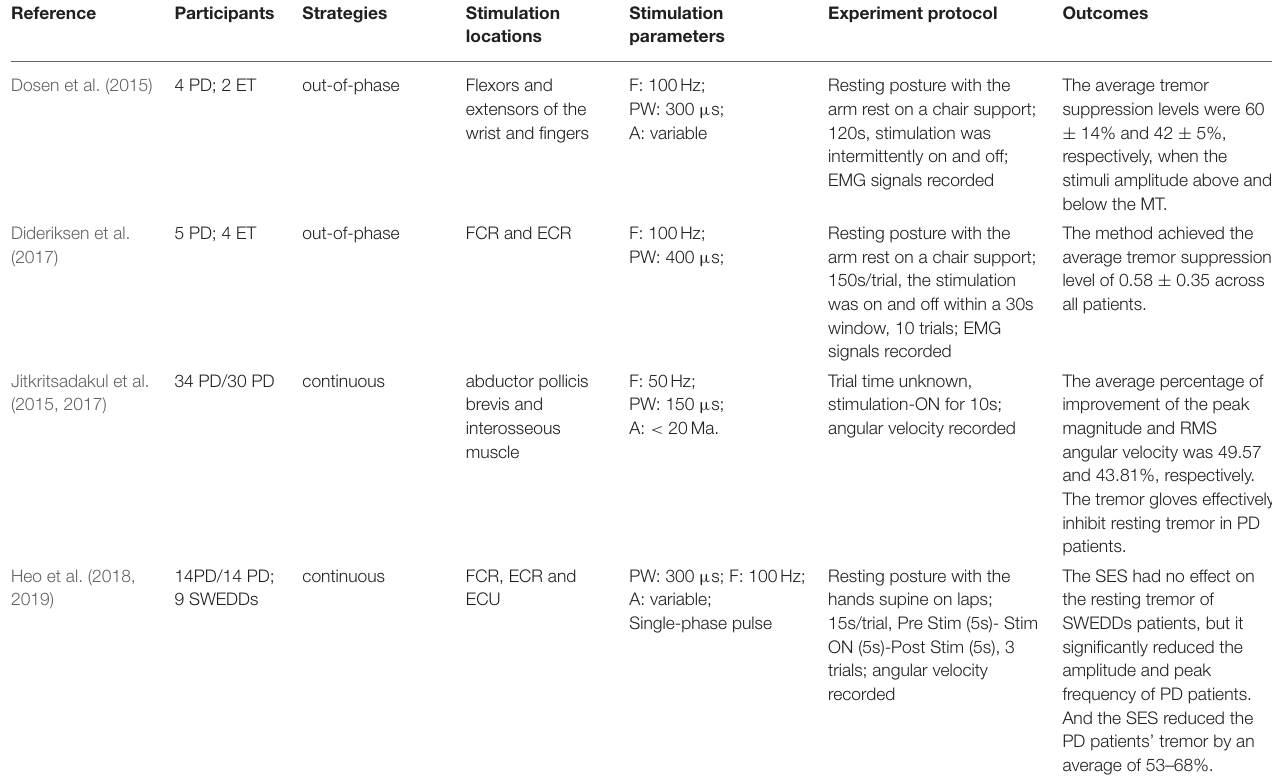
TABLE 2 | Summary of the methodologies and outcomes of sensory electrical stimulation (SES).